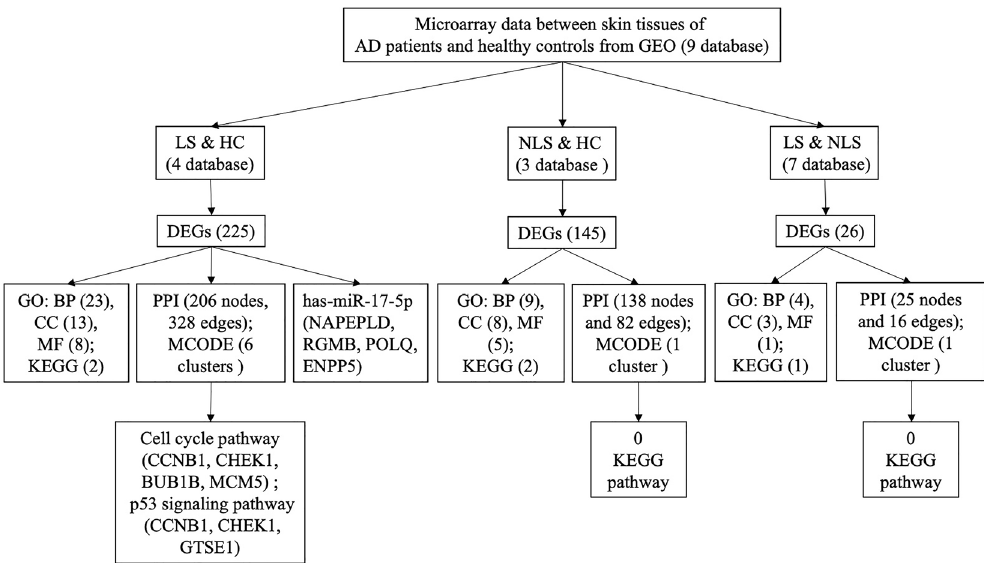
Figure 1. Flow diagram of the analysis strategy. DEG differentially expressed gene, GO gene ontology, BP biological process, CC cell component, MF molecular function, KEGG Kyoto Encyclopedia of Genes and